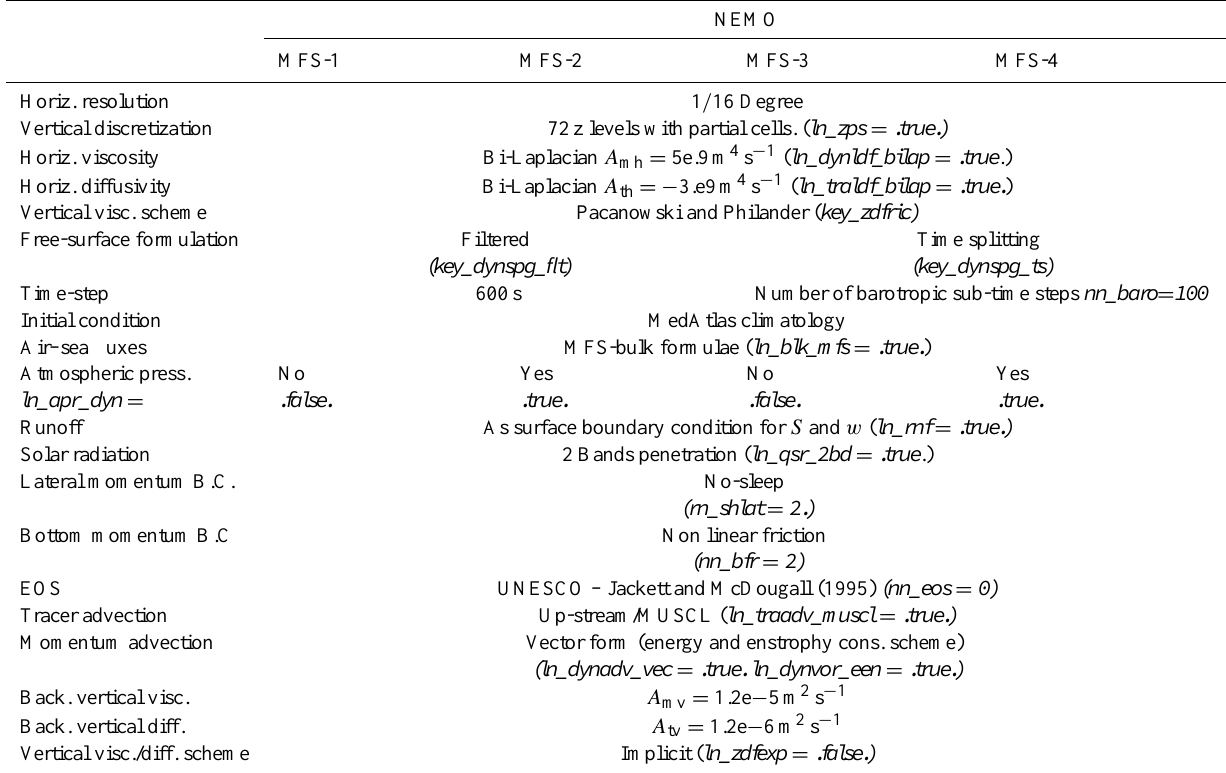
Table 1. NEMO–MFS configurations with corresponding cpp keys and namelist variables. NEMO MFS-1 MFS-2 MFS-3 MFS-4 Horiz. resolution 1 / 16 Degree 72z levels with partial cells. ( ln_zps =